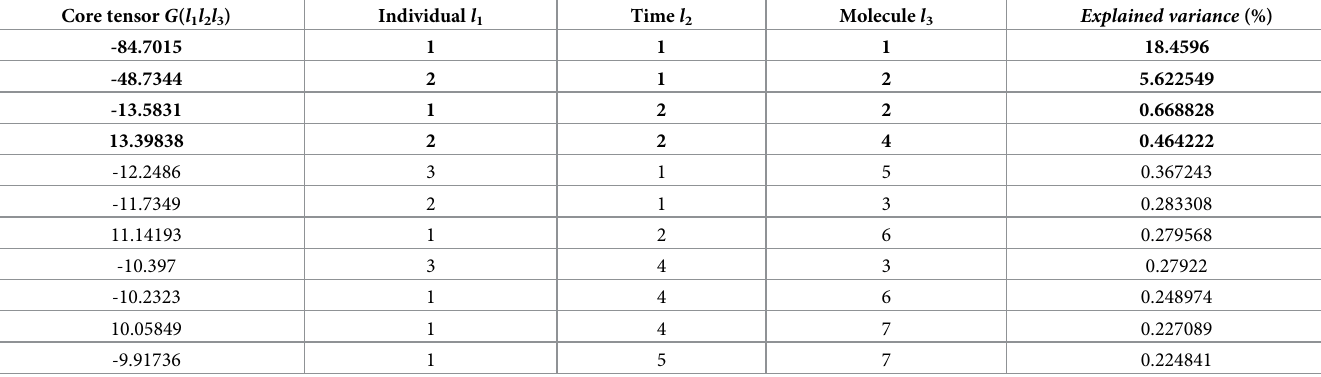
Table 1. Top ranked 10 G( l 1 l 2 l 3 )s with larger absolute values among l 1 , l 2 , l 3 . Core tensor G ( l 1 l 2 l 3